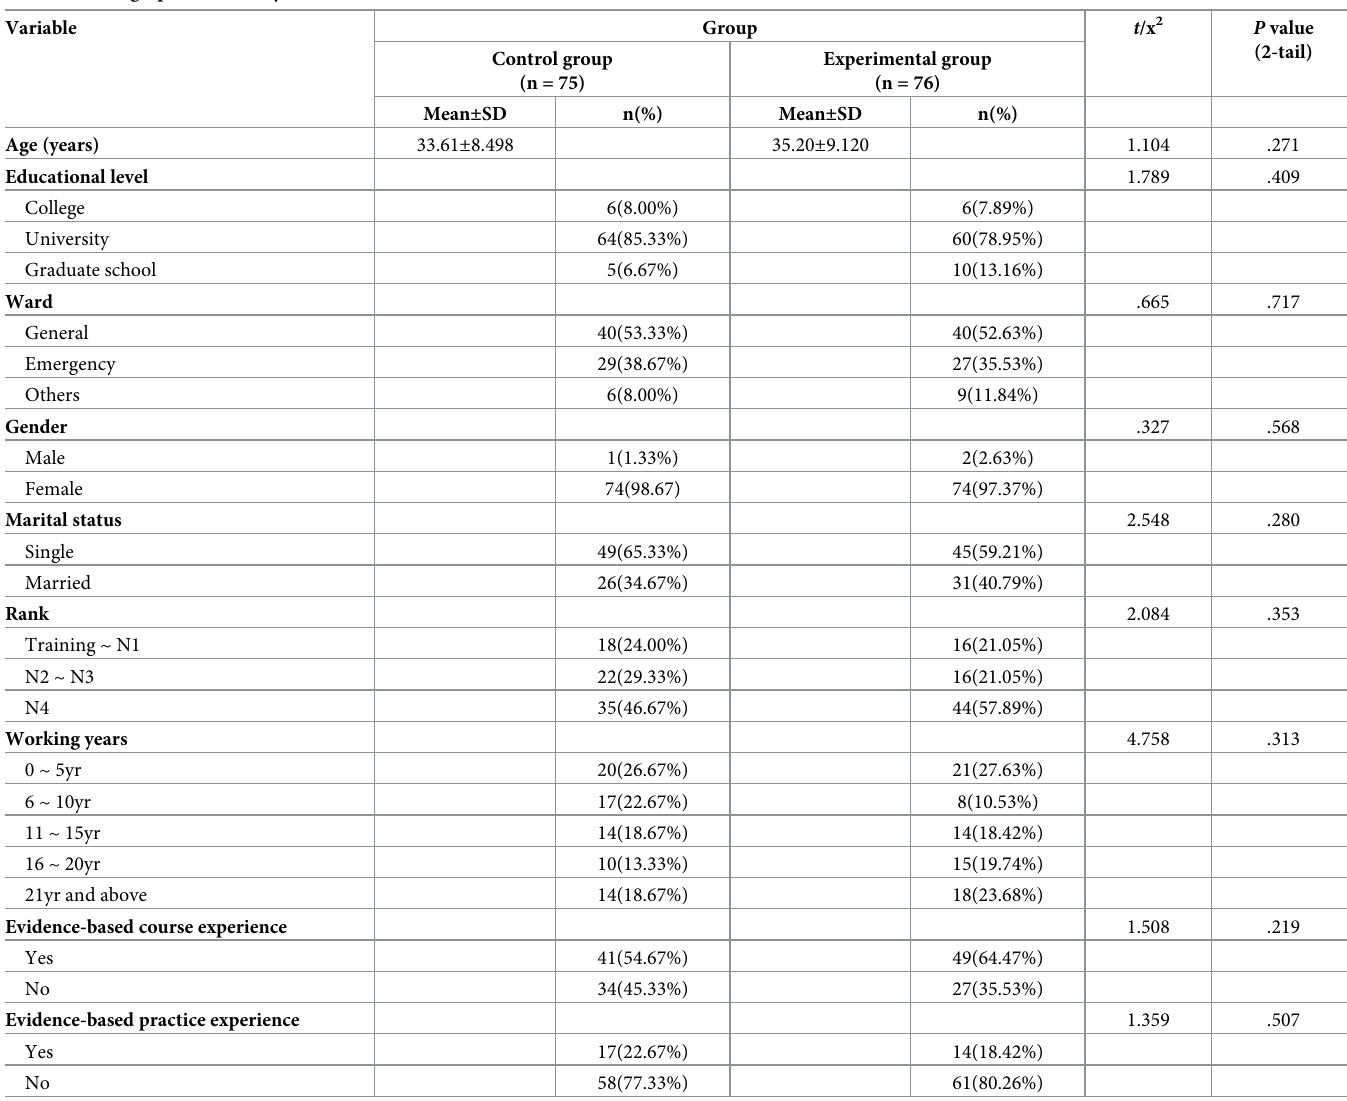
Table 1. Demographic data